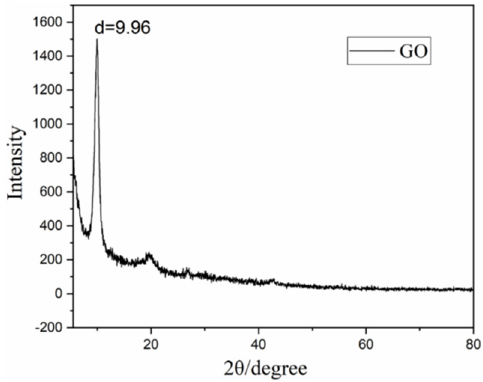
Figure 3. XRD fluorescence spectra of GO.